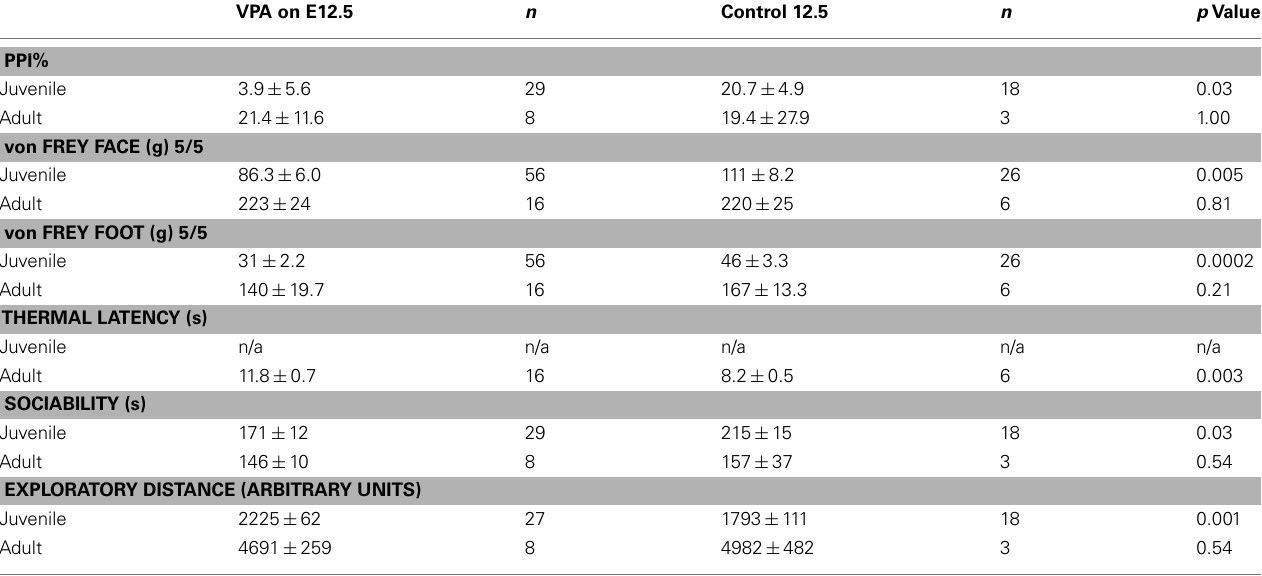
Table 2 | Summary of behavioral results for groups receiving a single dose ofVPA or saline.